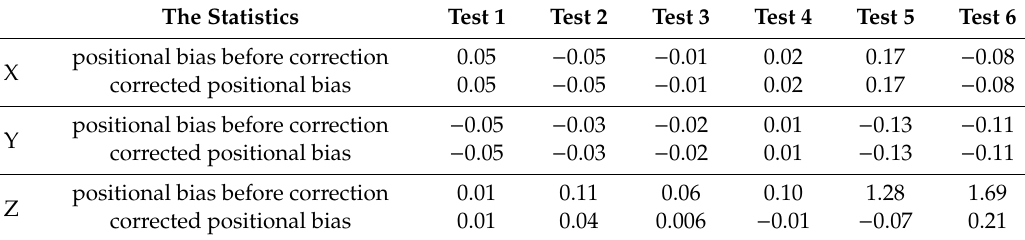
Figure 5. The hypothesis test based on Mahalanobis distance. Table 1. The statistics of bias correction (cm).